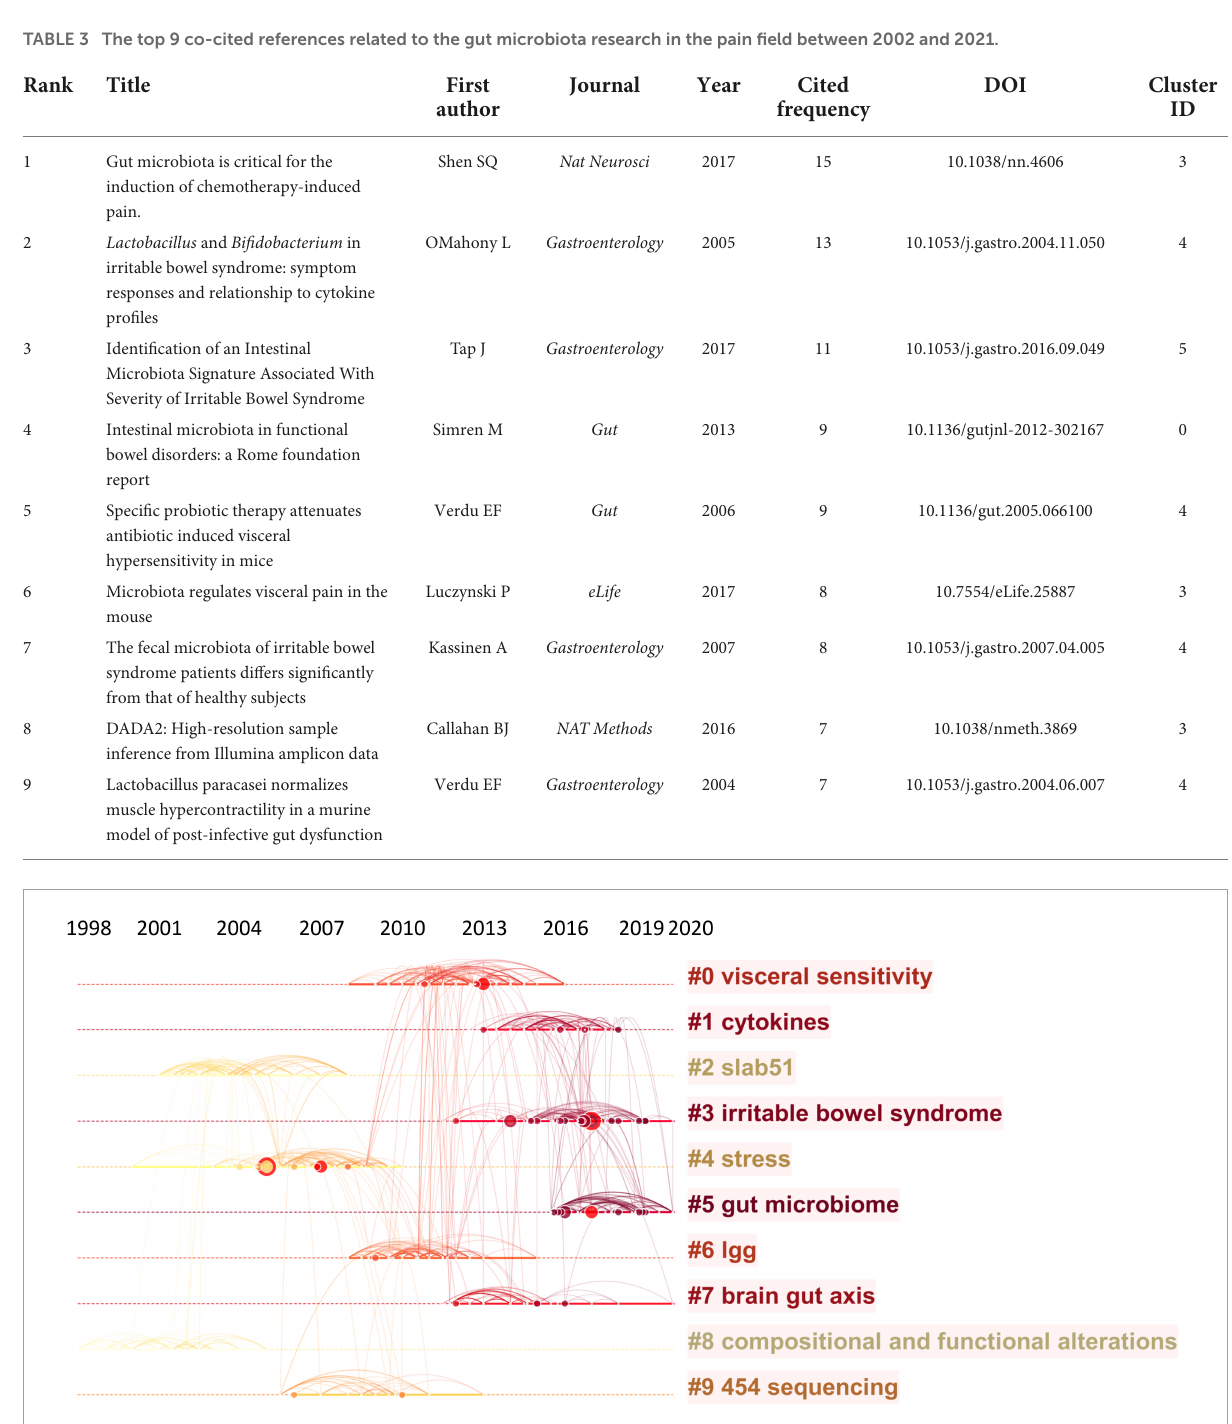
FIGURE6 Timeline visualization of the reference co-citation map. Large nodes or nodes with red tree-rings are either highly cited or have citation bursts in a given time slice. Right side = cluster